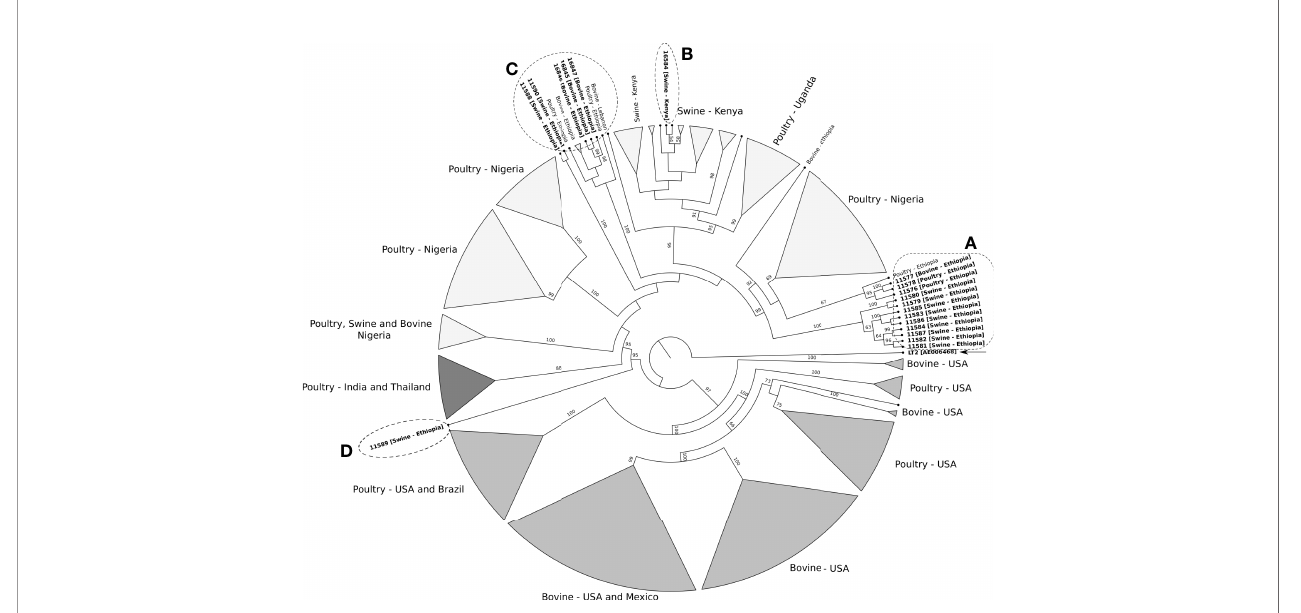
FIGURE 4 | Maximum likelihood phylogenetic tree of 248 ST198 Salmonella Kentucky strains recovered from farm animals. Salmonella Typhimurium LT2 (accession number AE006468) was used as outgroup and to root the tree. The clades support is indicated above or next to each branch as bootstrap values, calculated from 1,000 pseudo replicates. Clades A to D include the nineteen isolates from Ethiopia and Kenya and other Salmonella Kentucky from the database. ( Figure S1 shown the detailed phylogenetic